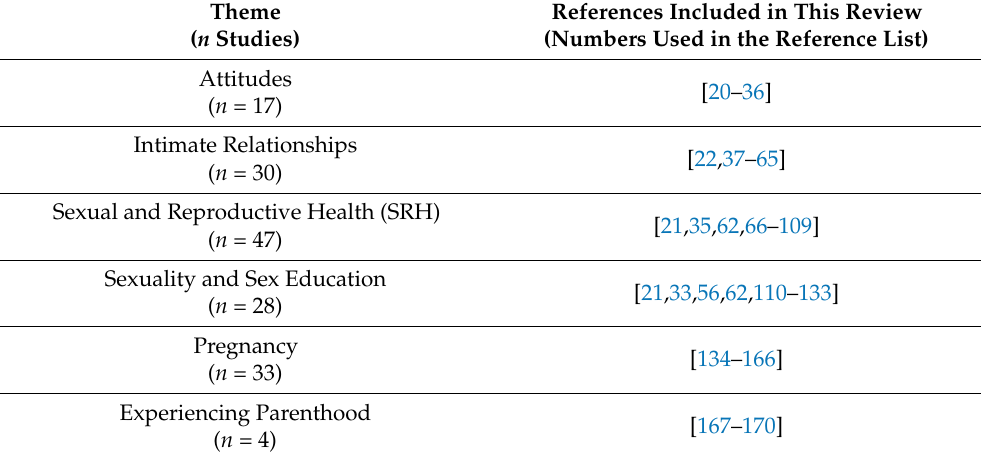
Table 3. References included in the review organized by